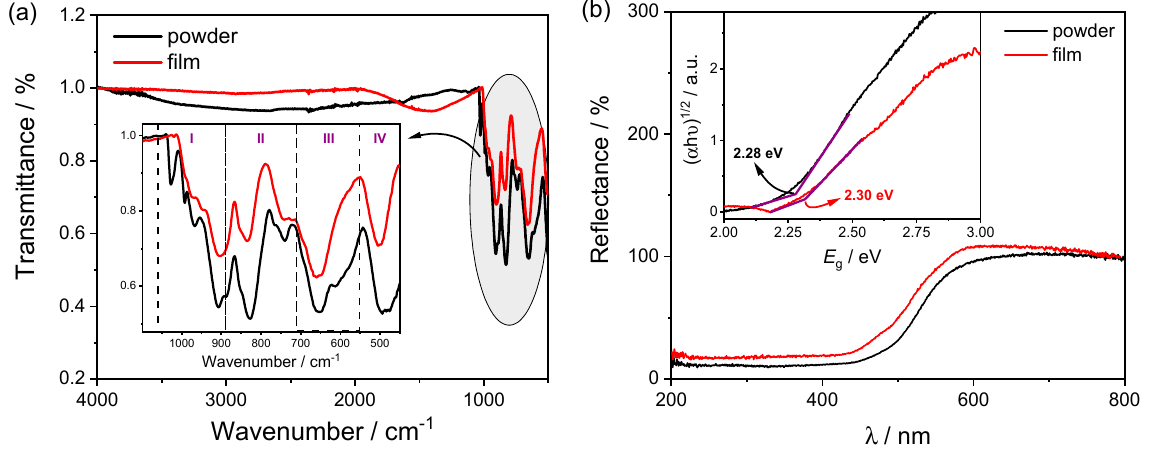
Figure 1. ( a ) Fourier-transform absorption infrared spectrum for the iron vanadate sample obtained by the successive ionic adsorption and reaction process. ( b ) UV–Vis diffuse reflectance and band gap energy evaluation from Wood–Tauc model. All measurements were performed for the powder and film iron vanadate.